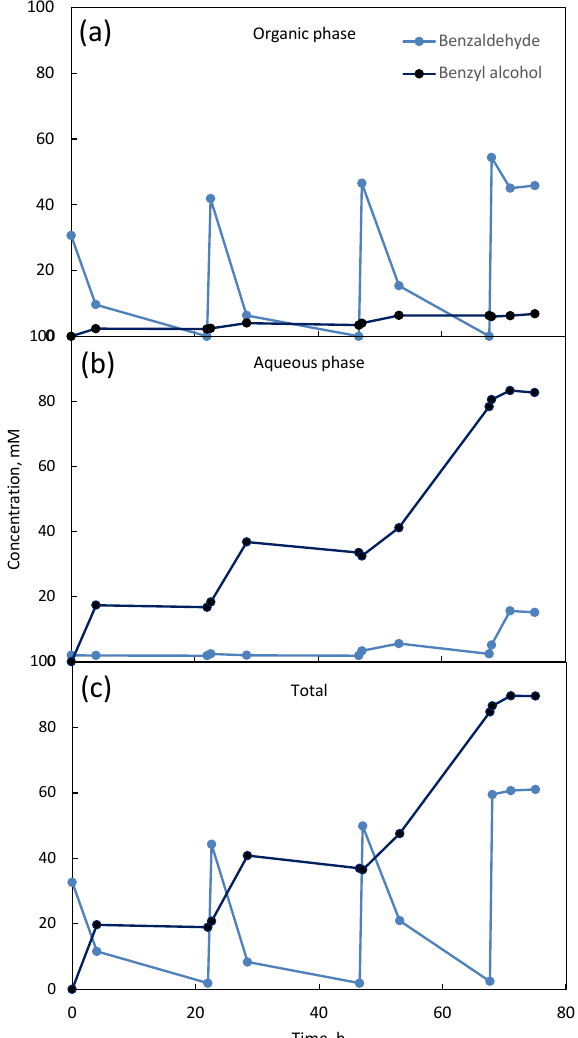
Figure 5. Two-phase stirred reactor system with 50 mL of total reaction volume. Benzaldehyde and benzyl alcohol concentrations over time in the organic phase ( a ), aqueous phase ( b ), and total concentration of both compounds in the system ( c ).